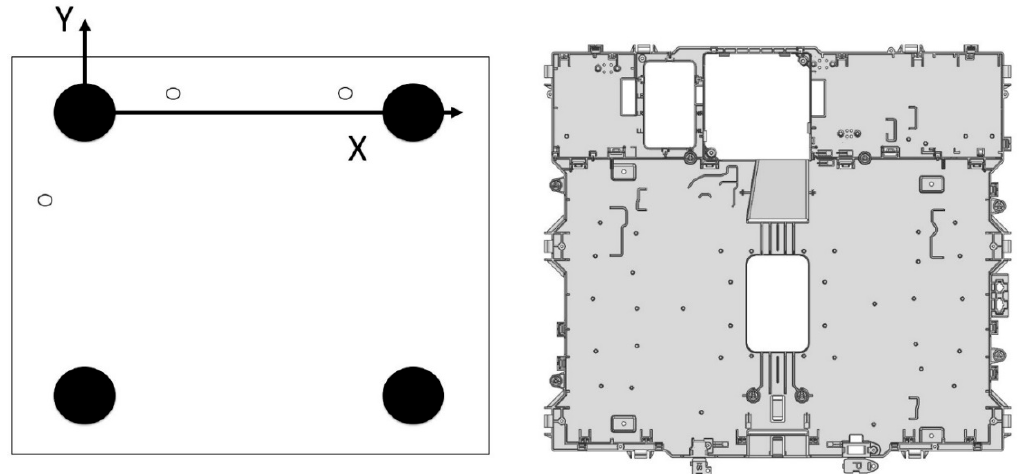
Figure 3. Base reference system to locate samples into a measurement tool.